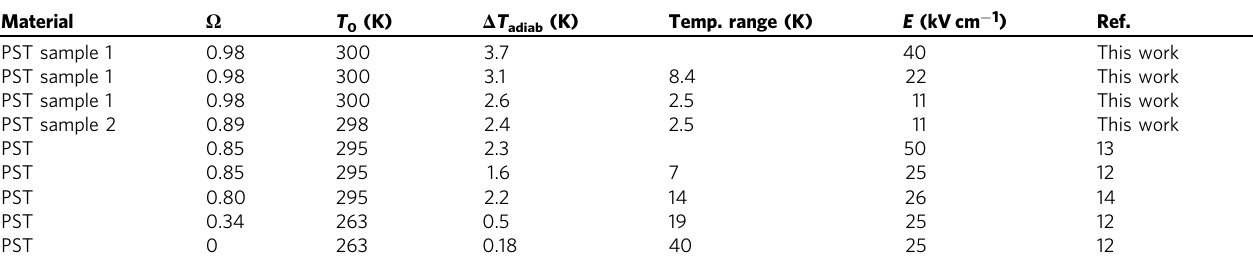
Table 1 In fl uence of B-site cation order on EC performance and temperature window of PST bulk ceramics. Material